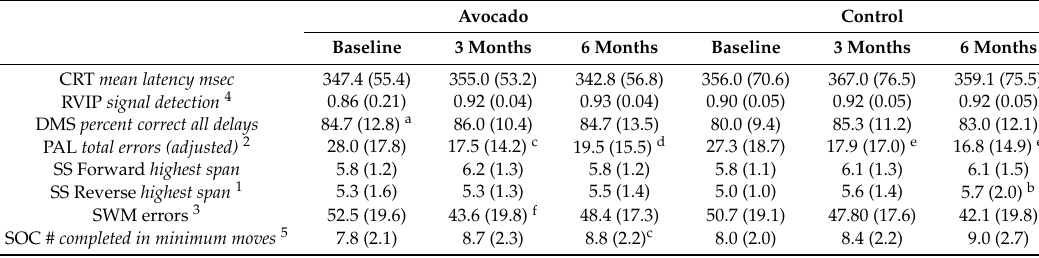
Table 4. Cognitive scores in healthy adults (>50 years) at baseline (0 month) and after three and six months of consuming one medium avocado a day (Avocado, n = 20) or one medium potato or one cup of chickpeas a day (Control, n = 20) for six months. Mean